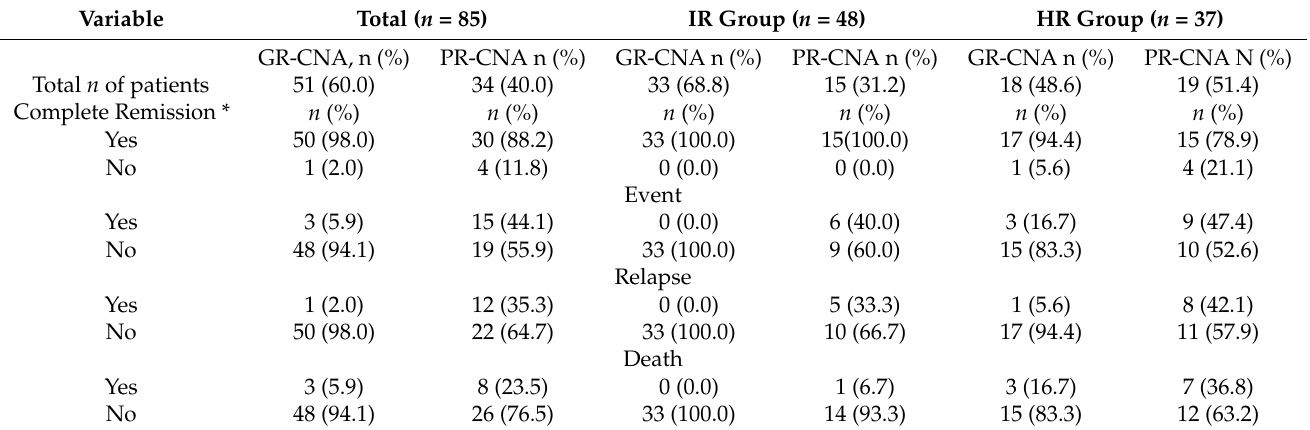
Table 2. Outcome characteristics of ALL patients stratified by